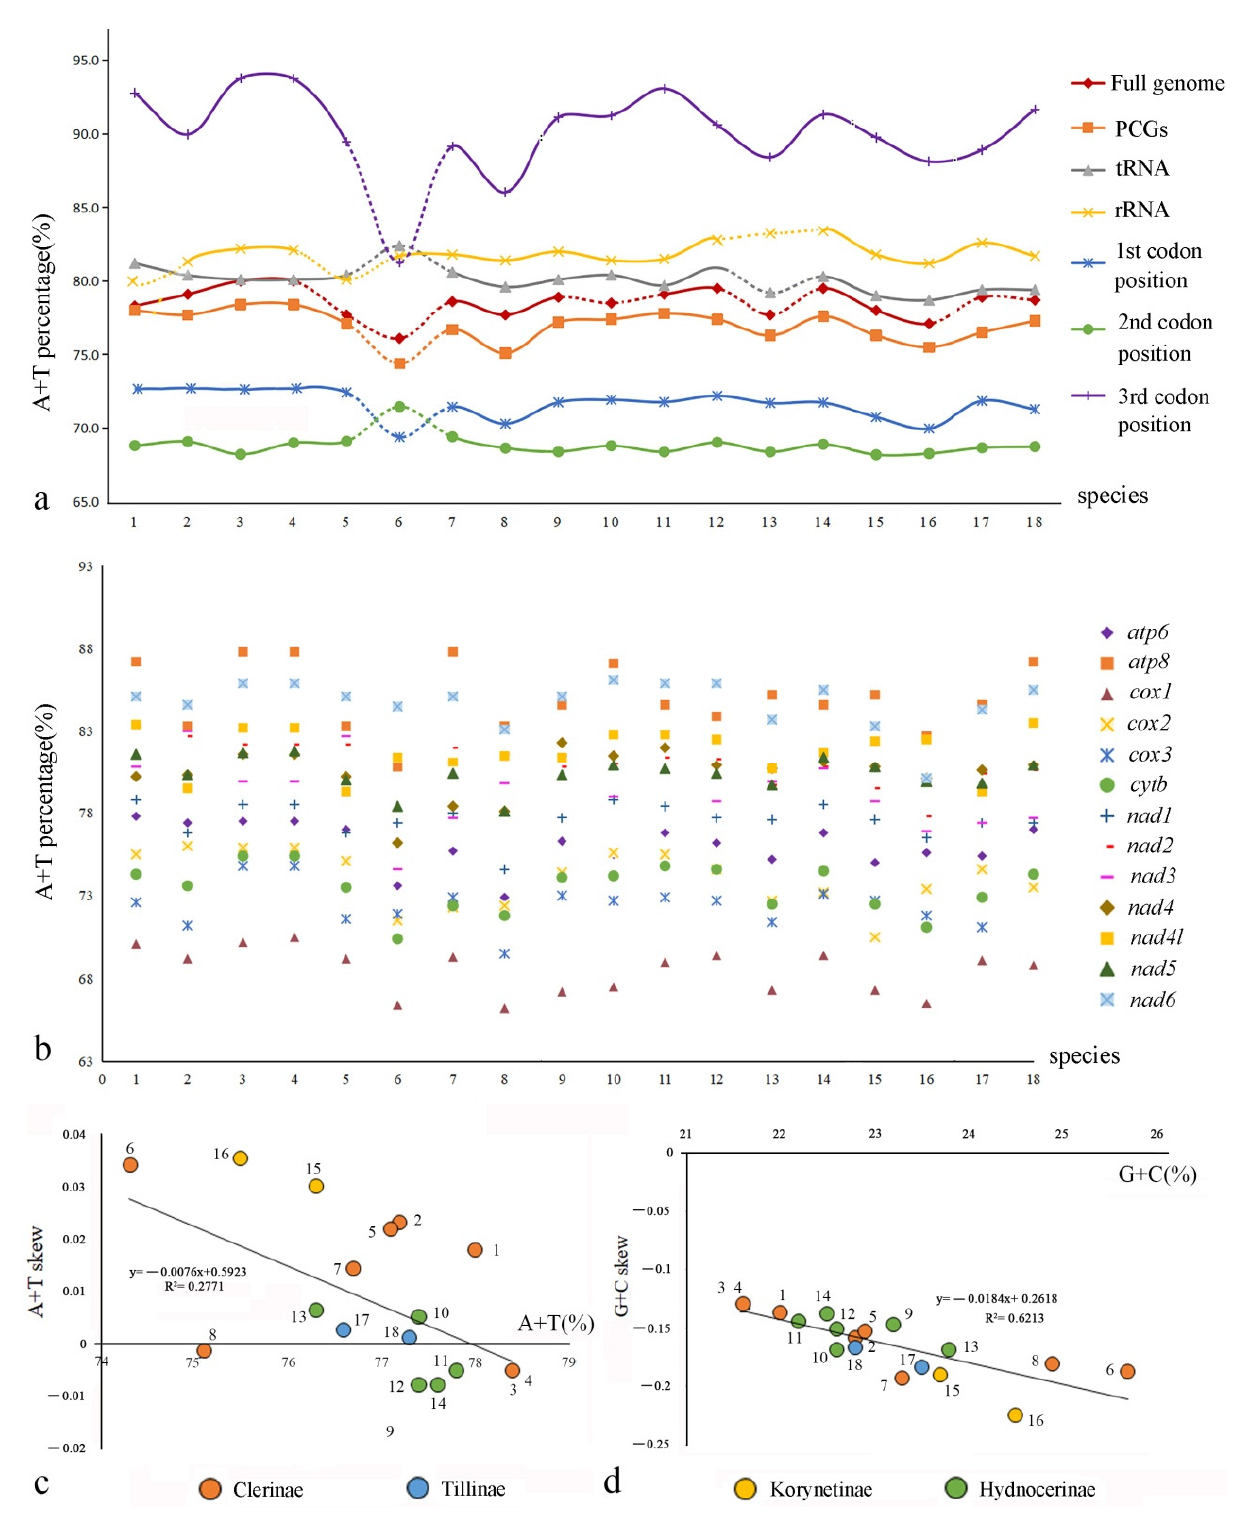
Figure 4. Comparison of nucleotide compositions of mitochondrial genomes among four subfamilies of Cleridae: ( a ) A+T% of different components or positions; ( b ) A+T% of different PCGs; ( c ) the correlations between A+T% and AT skew in the 13 PCGs; ( d ) the correlations between G+C% and GC skew in the 13 PCGs.